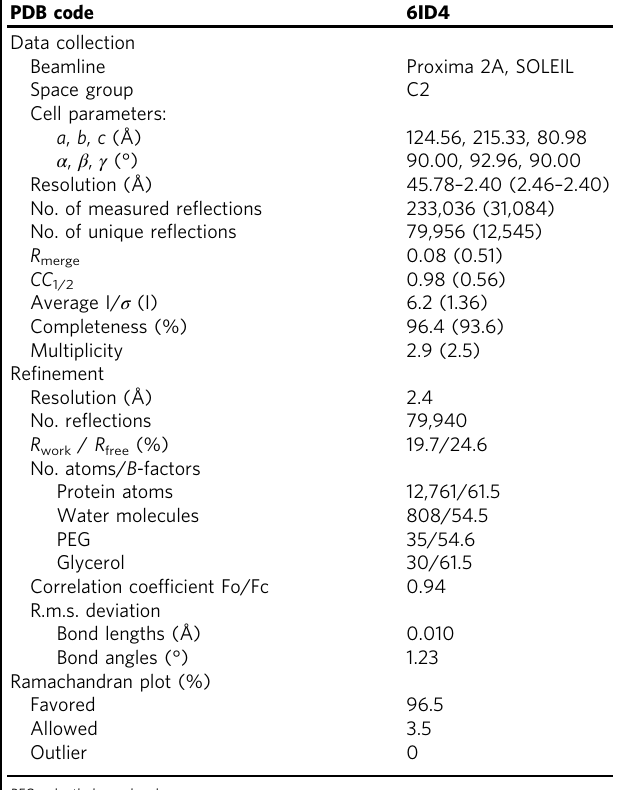
Table 1 Crystallographic data and re fi nement